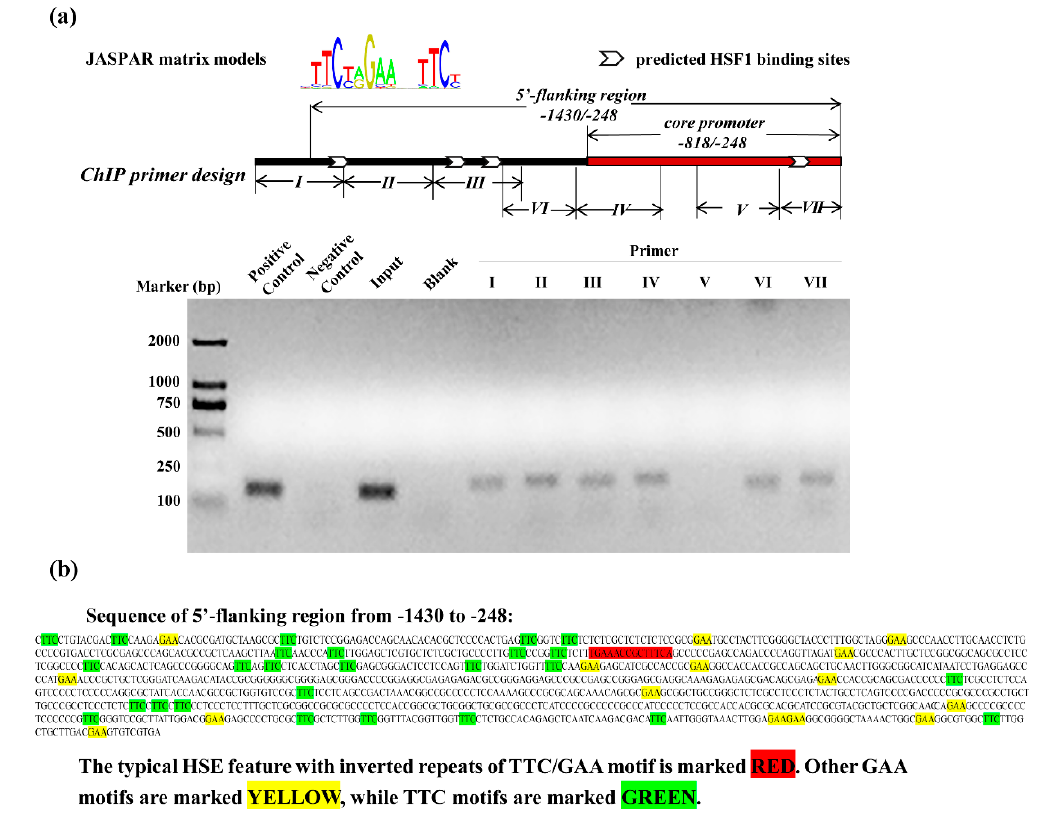
Figure 4. HSF1 interacted with the 5 ′ -flanking regions of SELENOF. ( a ) PCR amplification results of chromatin immunoprecipitation (ChIP) primers after protein-chromatin cross-linkage and immunoprecipitation. Locations of JASPAR predicted HSF1 binding sites and the designed ChIP primers were presented in the schematic map. ( b ) Manually searched results of both typical and less conserved variant of HSF1 Sequence-binding Elements (HSEs) in the sequences of SELENOF 5 ′ - flanking region from − 1430 to − 248. The data are representative of three independent experiments.